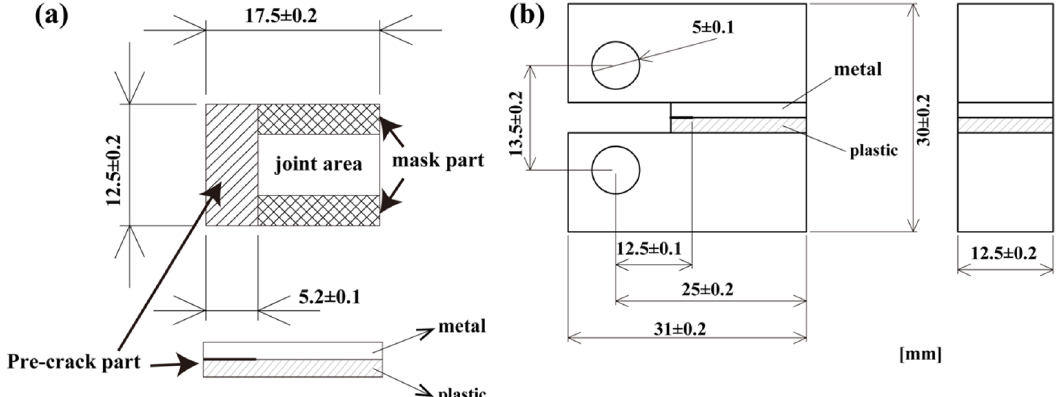
Fig. 11. Test specimen geometry and size for the measurement of interfacial fracture energy. (a) Metal/plastic laminate and (b) test specimen for the fracture